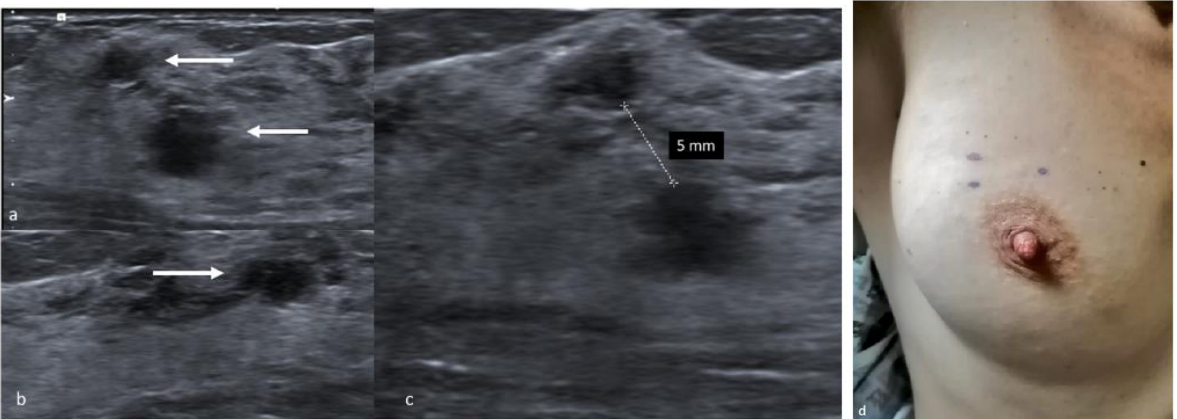
Figure 4. Preoperative skin tattoo. Transverse sonogram showing hypoechoic, round shaped multifocal masses with indistinct margins in the upper outer quadrant of the right breast ( a , b , arrows). The distance between separate lesions is measured ( c ). The dermographic skin markers of the tumor’s projection on the skin surface ( d ).